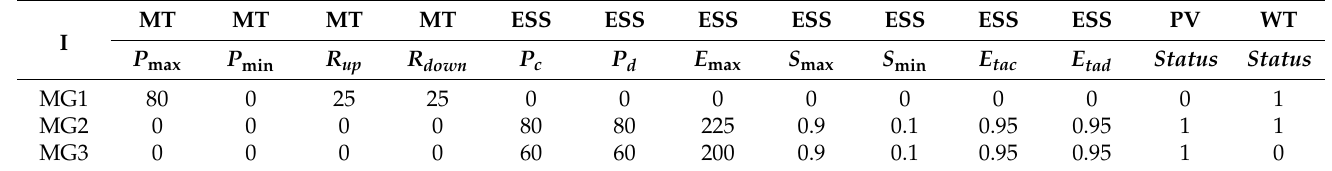
Table 1. Specifications of production units in each microgrid.